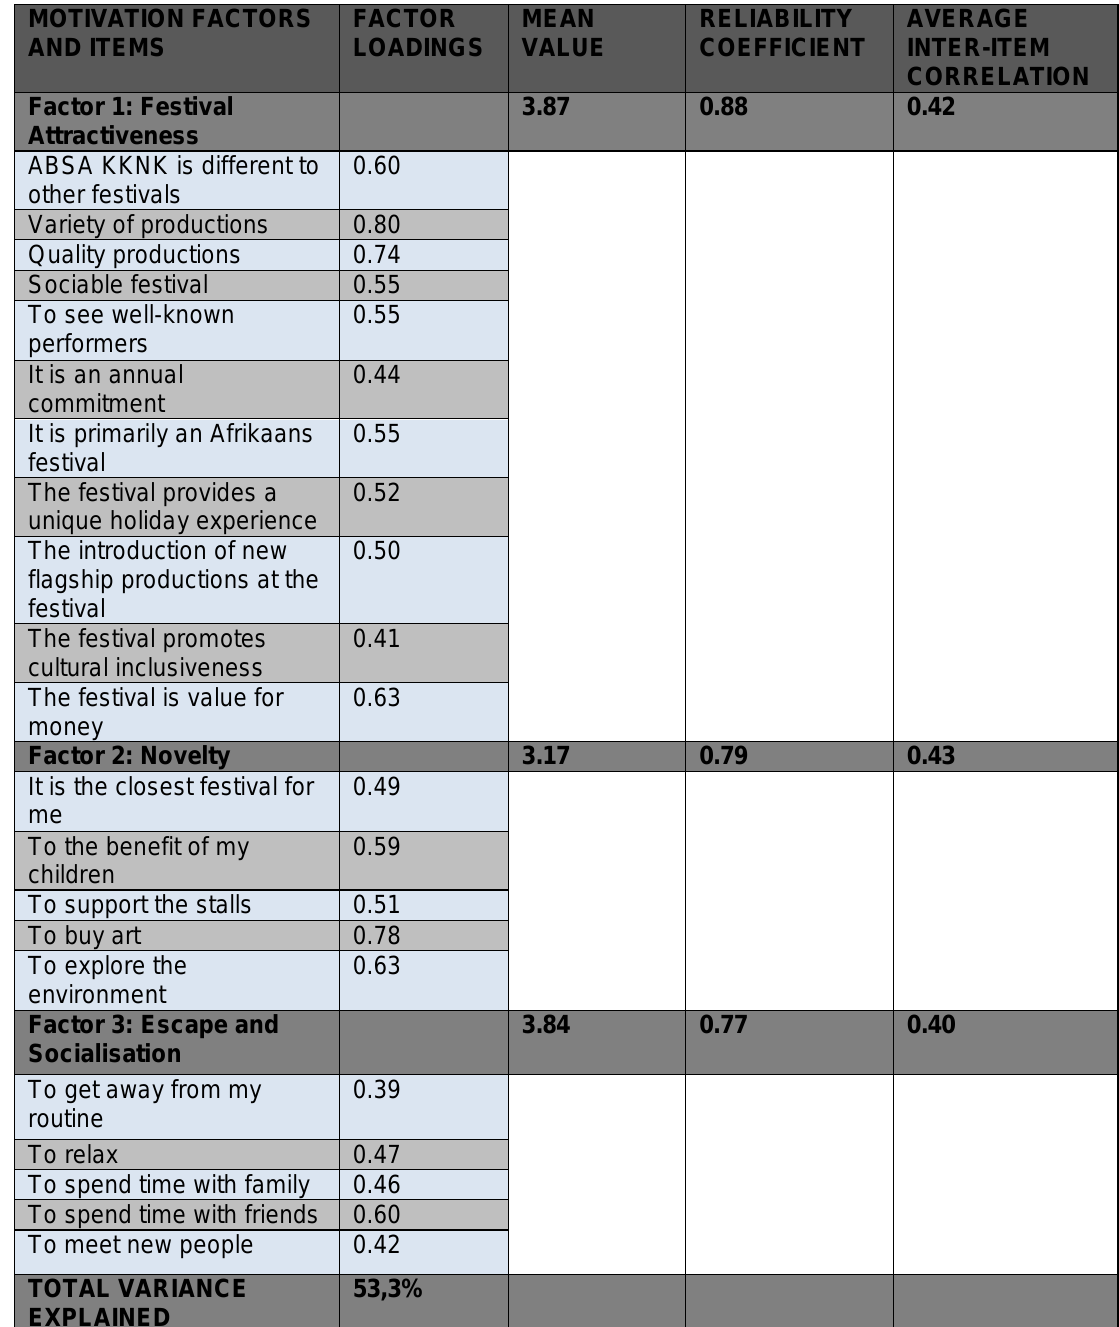
Table 2: Factor analysis results of KKNK visitors’ travel